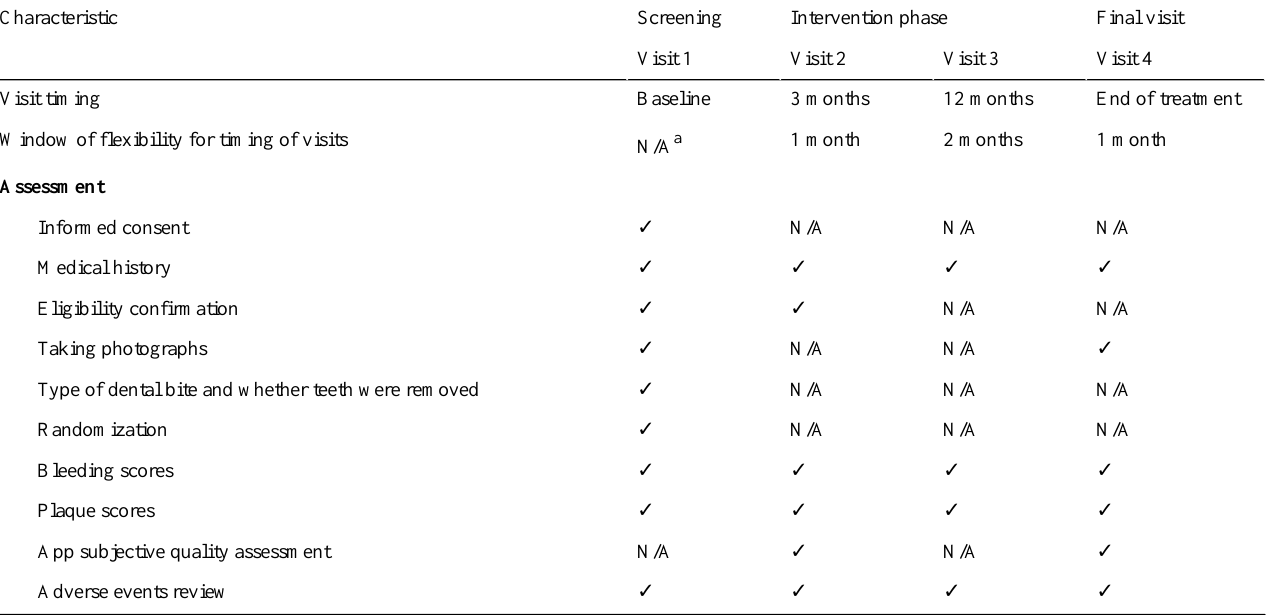
Table 1. Schedule of enrolment and assessments (groups A, B, and C will receive different versions of the intervention, the My Braces app).